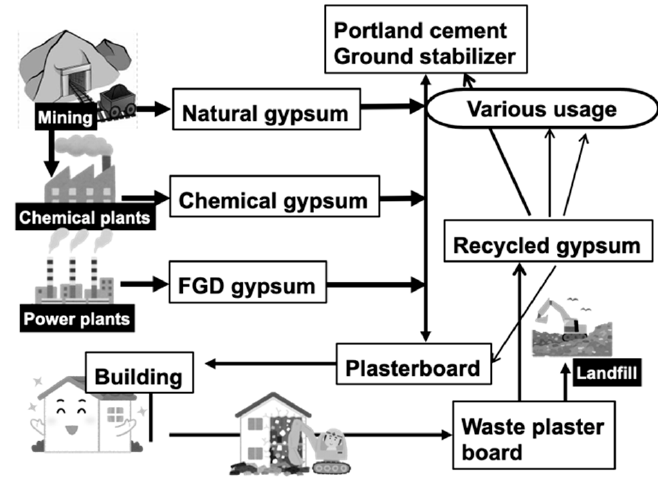
Figure 1. Material flow of gypsum in Japan. FGD: flue gas desulfurization.